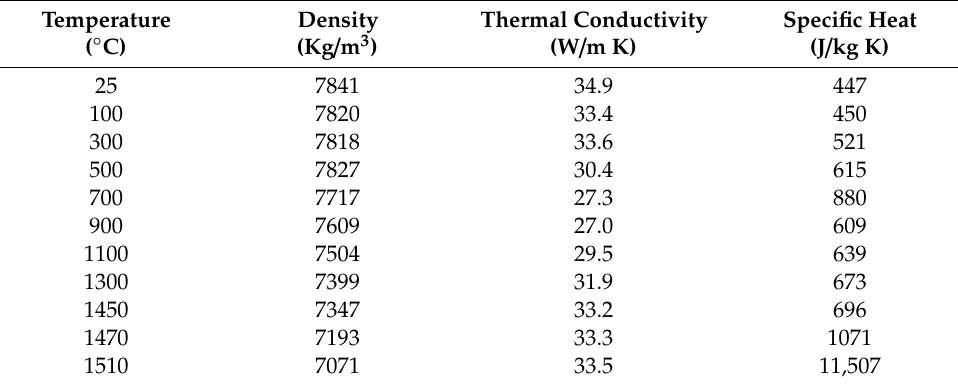
Table 3. Thermal properties of SLM fabricated low-alloy steel at di ff erent temperatures.